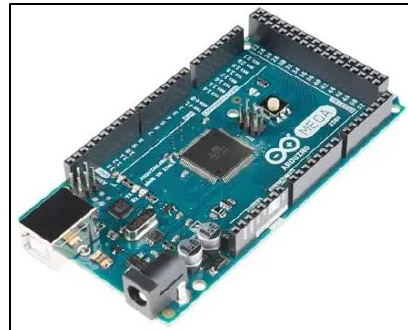
Figure 9: Arduino MEGA 2560.